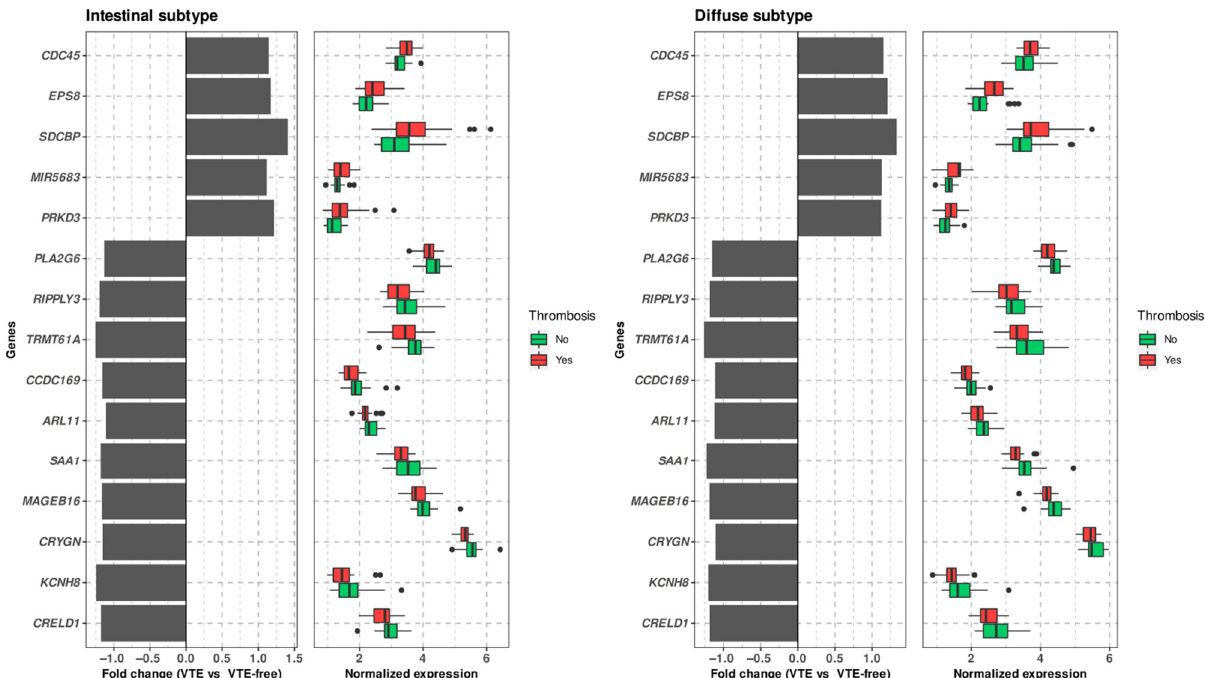
Figure 1. Selected genes from the stratified analysis by Lauren histopathological subtypes. Differential expression of these genes between individuals with thrombosis and controls is shown. These genes also had an adjusted p -value < 0.05 in both analyses. VTE: Venous thromboembolism. Table 2. Differentially expressed genes between patients with venous thromboembolism and con- 3.3. Conditional Logistic Regression by Histopathology in the Overall Cohort trols, in the diffuse subtype.